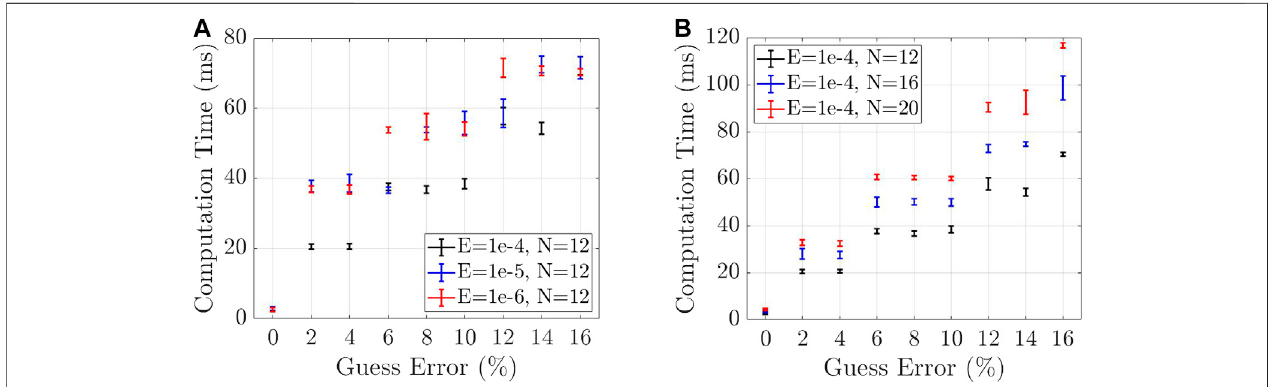
FIGURE 13 | (A) : Computation time required for solving a solution to the BVP changes with decreasing tolerable error ( E ) for a constant number of nodes. (B) : Computationtimerequired forsolvingasolutiontotheBVP changeswithanincreasingnumber ofnodes ( N ) andincreasingpercentageerrorsfromavalidsolution,fora constant tolerable